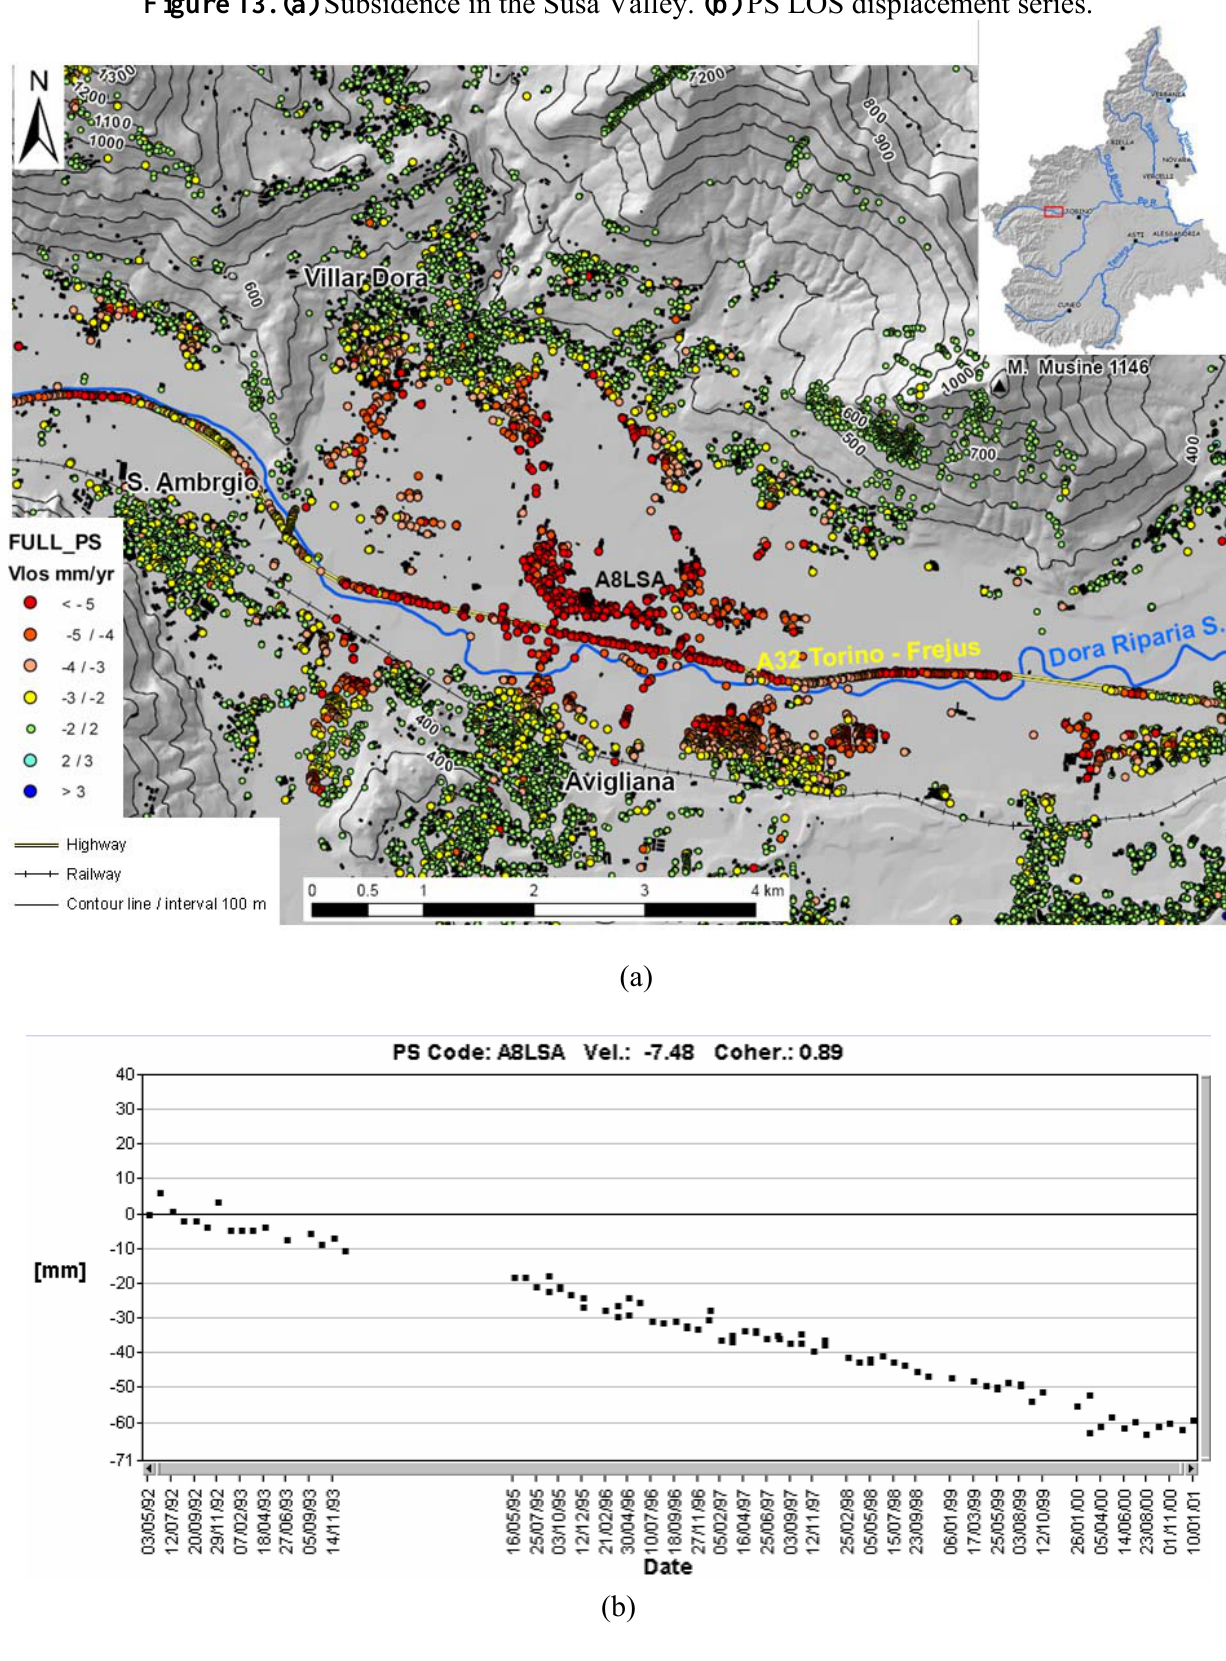
Figure 13. (a) Subsidence in the Susa Valley. (b) PS LOS displacement